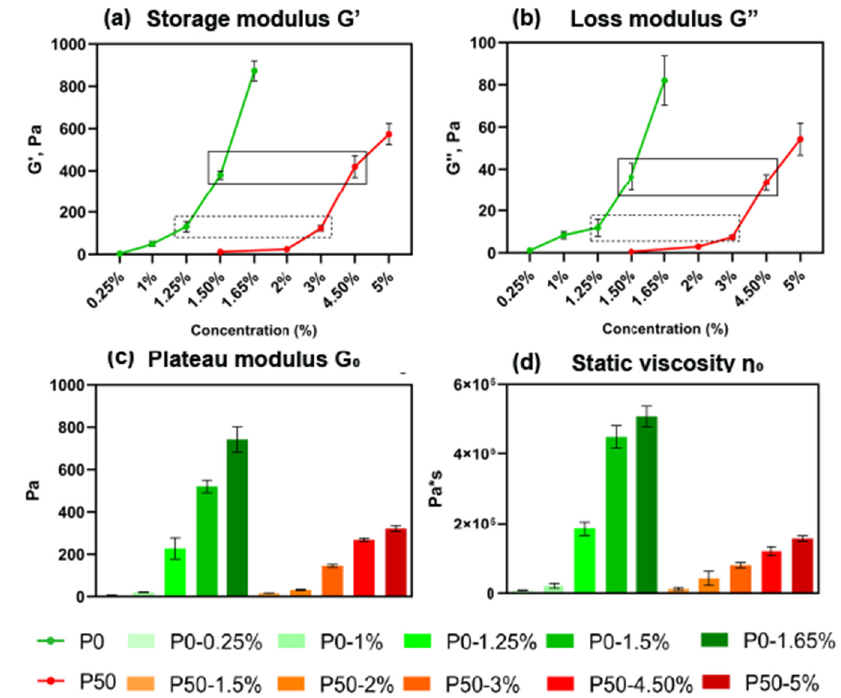
Figure 3. Rheological properties of pectin hydrogels: ( a ) storage modulus G’; ( b ) loss modulus G’’; ( c ) plateau modulus G 0 ; ( d ) static viscosity η 0 , n = 3. The pairs of samples P0-1.25% and P50-3%, P0-1.5% and P50-4.5%, with similar